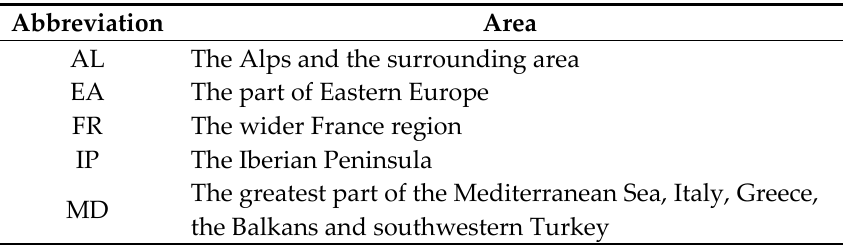
Figure 1. Topography (m) of the domain of study. The boxes represent the division of the area into five sub-regions according to the common EURO-CORDEX analysis domain. Table 1. The five sub-regions and their area of